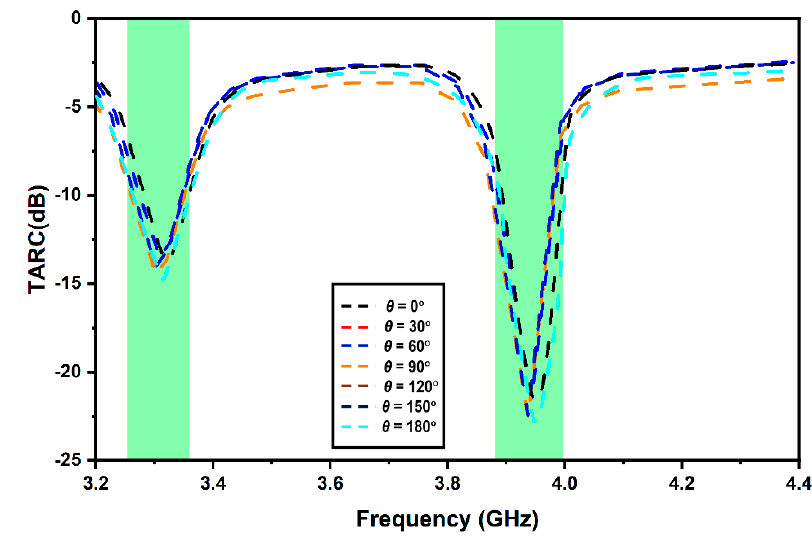
Figure 11. Proposed MIMO antenna TARC.